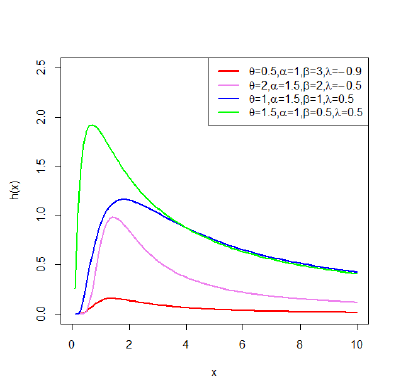
Figure 2 – Plot of the hrf of ETF distribution for given parameter